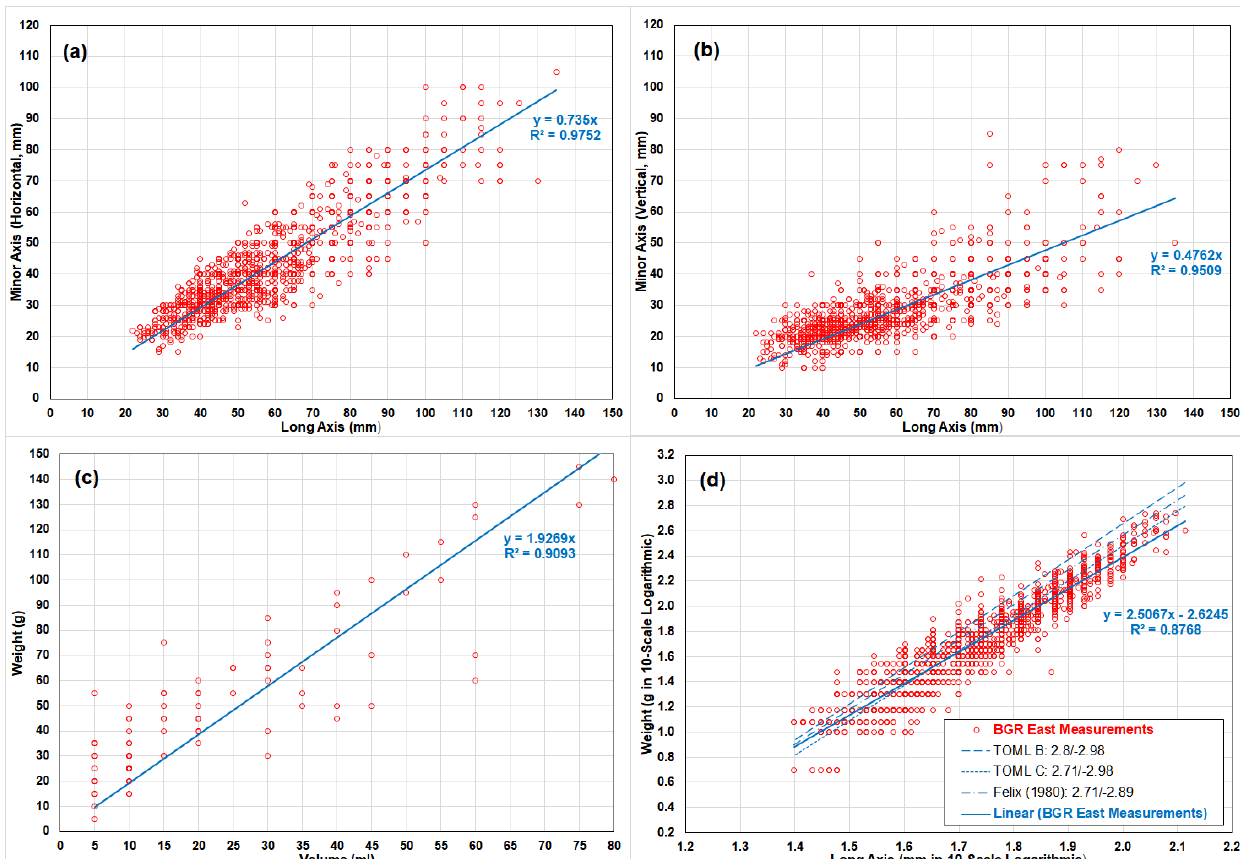
Figure 5. Linear Regression between Nodule Dimensions and Weights for BGR East Region. Data source [14]. Note in ( d ) the legend shows the slopes and intercepts of the linear regressions of the data of Felix [13] and TOML [4], where the intercepts are converted from cm to mm (in logarithmic scale).